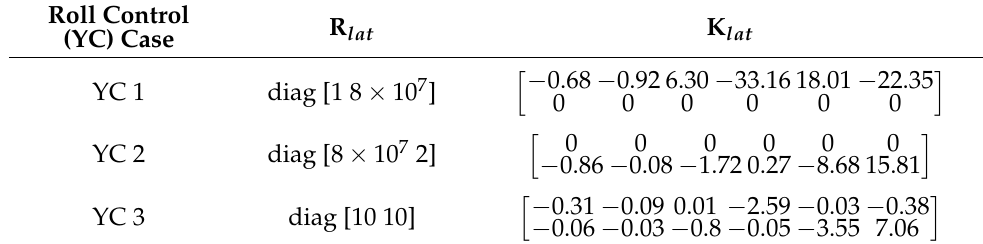
Table 7. Simulation parameters for yaw control (YC) cases.